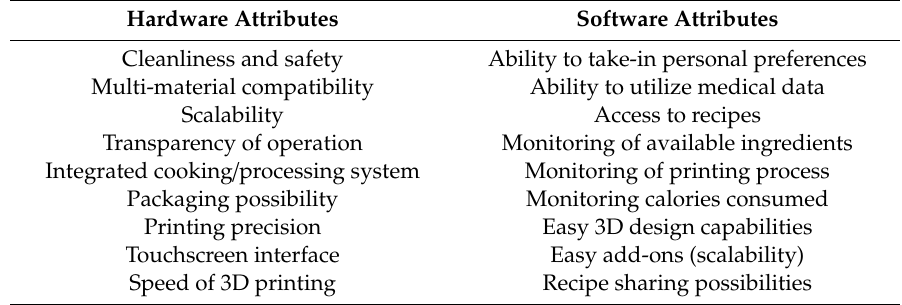
Hardware and software attributes of 3D food printer system identified during the exploratory phase.